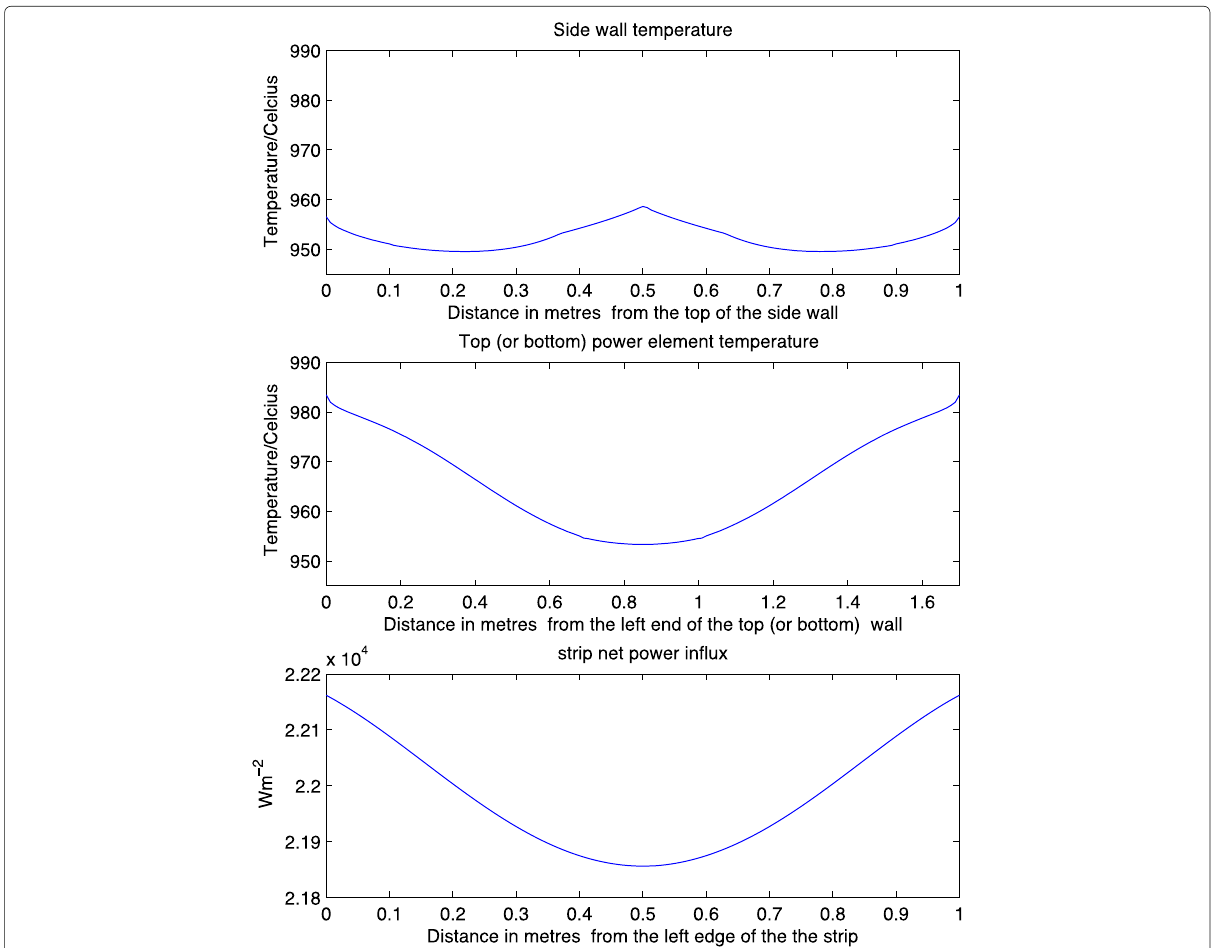
Fig. 10 Case 1: T S = 500 ◦